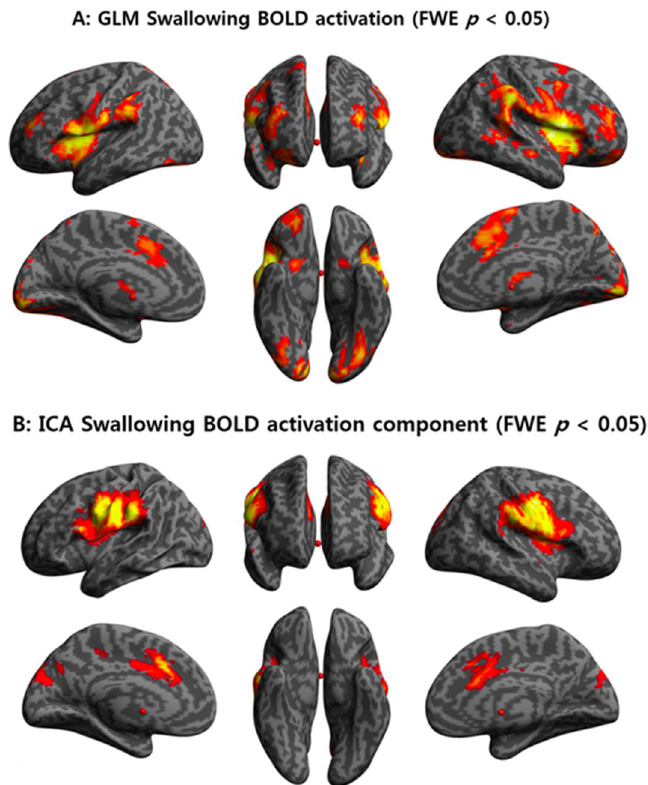
Figure 1. BOLD signal in swallowing tasks in general linear model and independent component analyses. ( A ) In GLM analyses, significant BOLD signals were seen in both the lateral precentral gyri, postcentral gyri, anterior insular cortices, supramarginal gyri, pre-SMA, thalami, and visual cortices. ( B ) IC 17 showed the strongest positive correlation with BOLD signal (r = 0.64, p < 0.001) in the swallowing task in both the lateral precentral gyri, postcentral gyri, anterior insular cortices, supramarginal gyri, pre-SMA, and anterior cingulate gyri. GLM, general linear model; BOLD, blood oxygen level-dependent; SMA, supplementary motor area; IC, independent component; FWE, family-wise